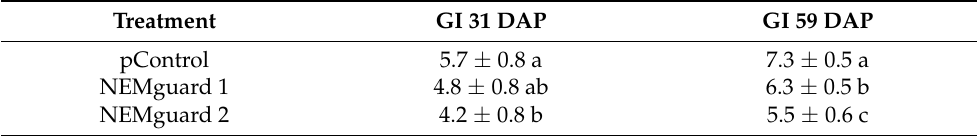
Table 2. Root gall indexing (GI) of tomato plants grown in small pots for 31 and 59 days after planting (DAP) to evaluate the nematicidal effect of NEMguard ® DE against Meloidogyne incognita . Treatment GI 31 DAP GI 59 DAP pControl 5.5 ± 0.6 c Root gall indexing (GI) was determined according to Zeck [25]. Values are means of n = 6, same letter in the same column indicate no significant differences using a one-way ANOVA (post-hoc Tukey HSD test). NEMguard 1 = NEMguard ® DE applied before planting; NEMguard 2 = NEMguard ® DE applied before planting followed by a repeated application 24 days after planting. Positive (p) control = control with M. incognita , negative (n) control = soil free of M. incognita .